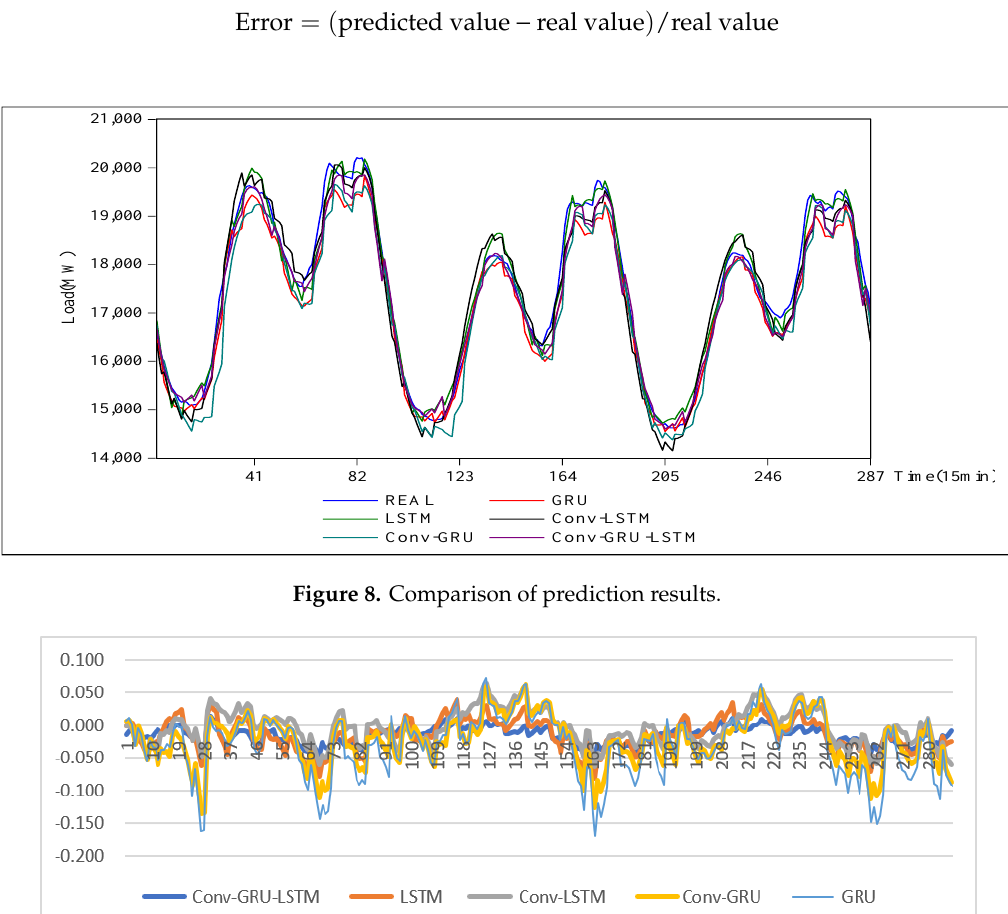
Figure 9. Error of the five models.